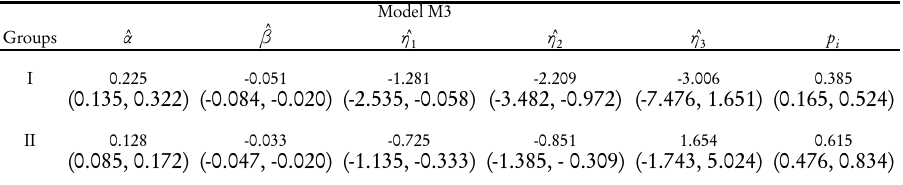
Posterior summary of the regression parameters of model M3. In brackets we show the 2.5 and 97.5 percentiles used for defining the 95% credible interval